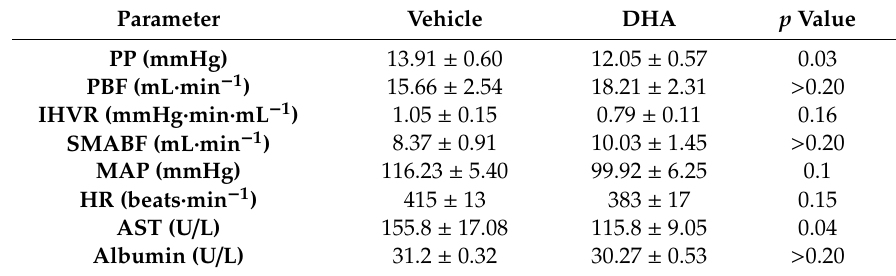
Table 3. E ff ects of DHA administration on hepatic and systemic hemodynamics and serum markers in a rat model of advanced chronic liver disease